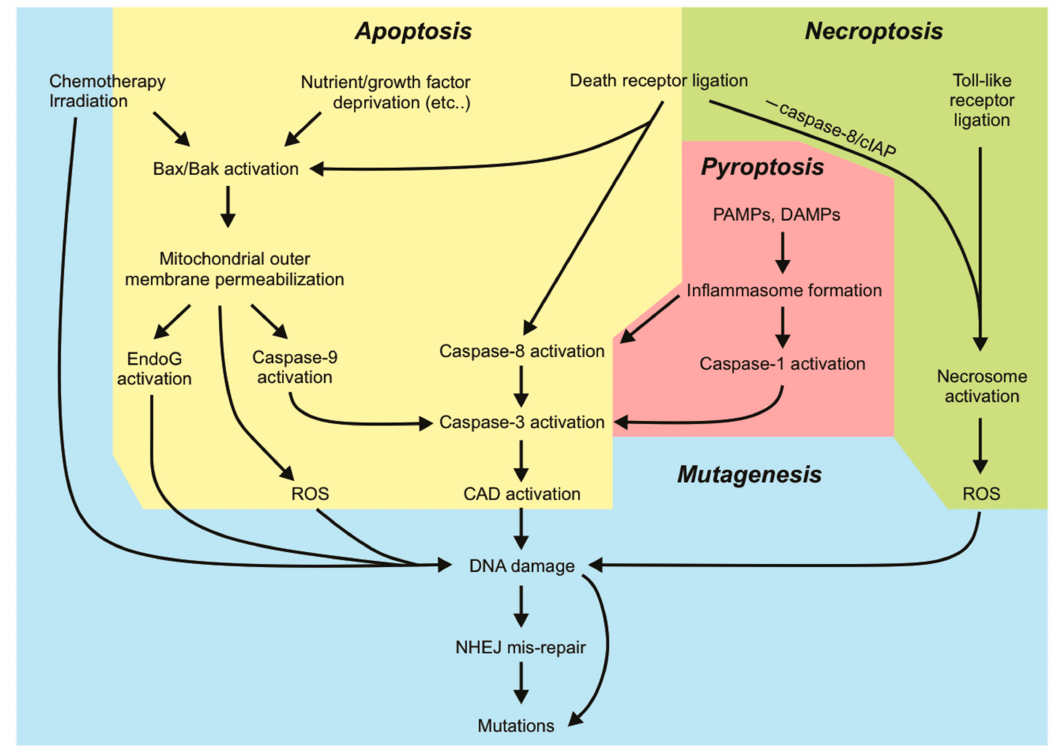
Figure 4. Summary of the key aspects of cell death pathways that can lead to